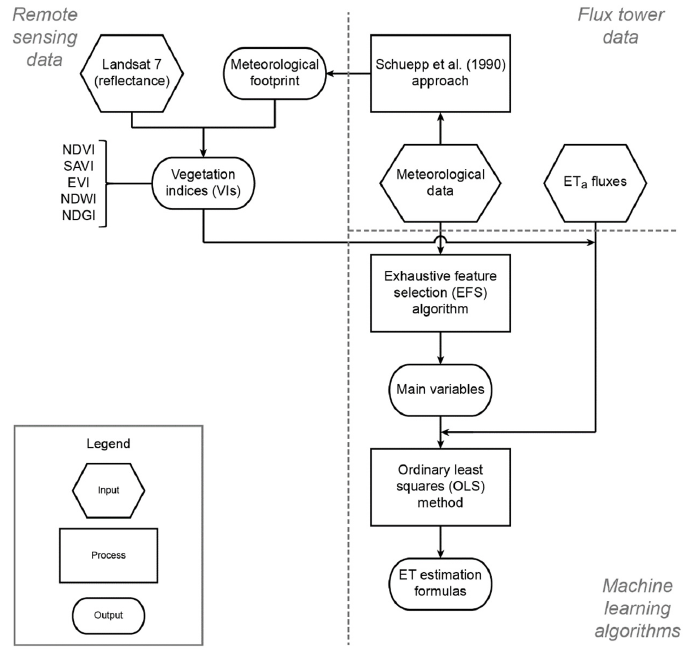
Figure 3. Flowchart of the methods used in this study. Remote sensing, and flux, and meteorological data were used to obtain the main variables and actual evapotranspiration (ET a ) estimate formulae by the application of machine learning algorithms.